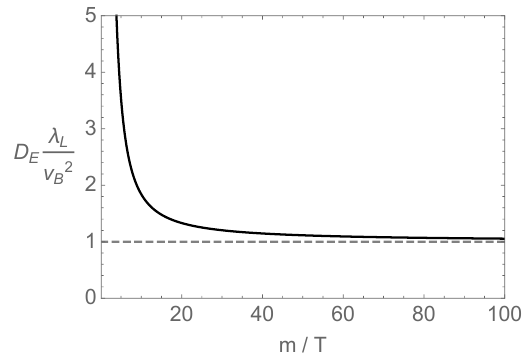
Figure 1 . The diffusion bounds of D E (3.8) with N = 1 . λ L = 2 πT , the butterfly velocity v B is (3.6). The dashed line denotes the lower bound